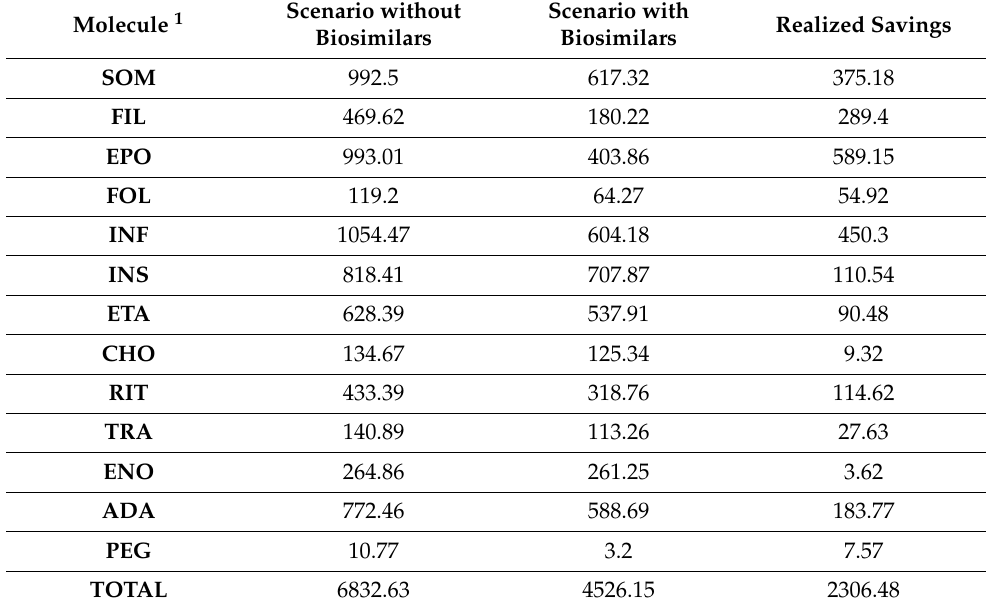
Table 1. Results of the BIA ( € million